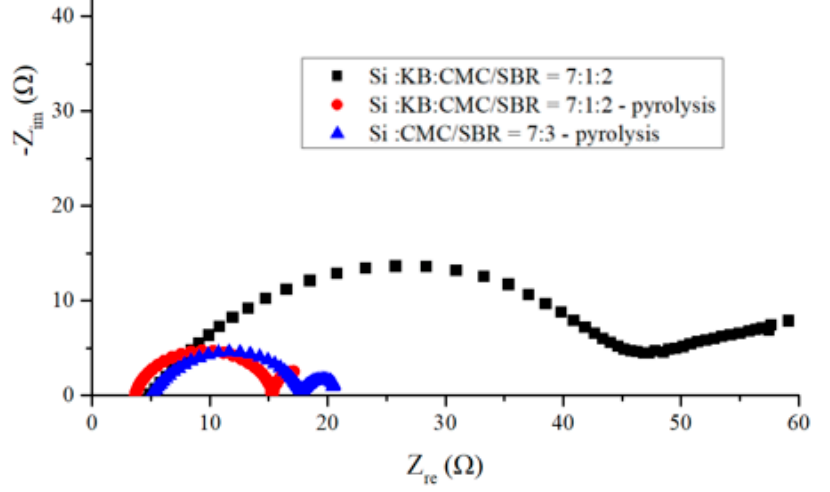
Figure 9. Electrochemical impedance spectra of anode before discharge–charge cycling experiments measured from three sets of anodes made of (black square) electrode with silicon flake: KB–CMC/SBR = 70%:10%:20% in weight ratio; (red dots) pyrolytic electrode with silicon flakes: KB–CMC/SBR = 70%:10%:20% in weight ratio; (blue triangle) pyrolytic electrode with silicon flakes–CMC/SBR = 70%:30% in weight ratio without conductivity enhancement additive.